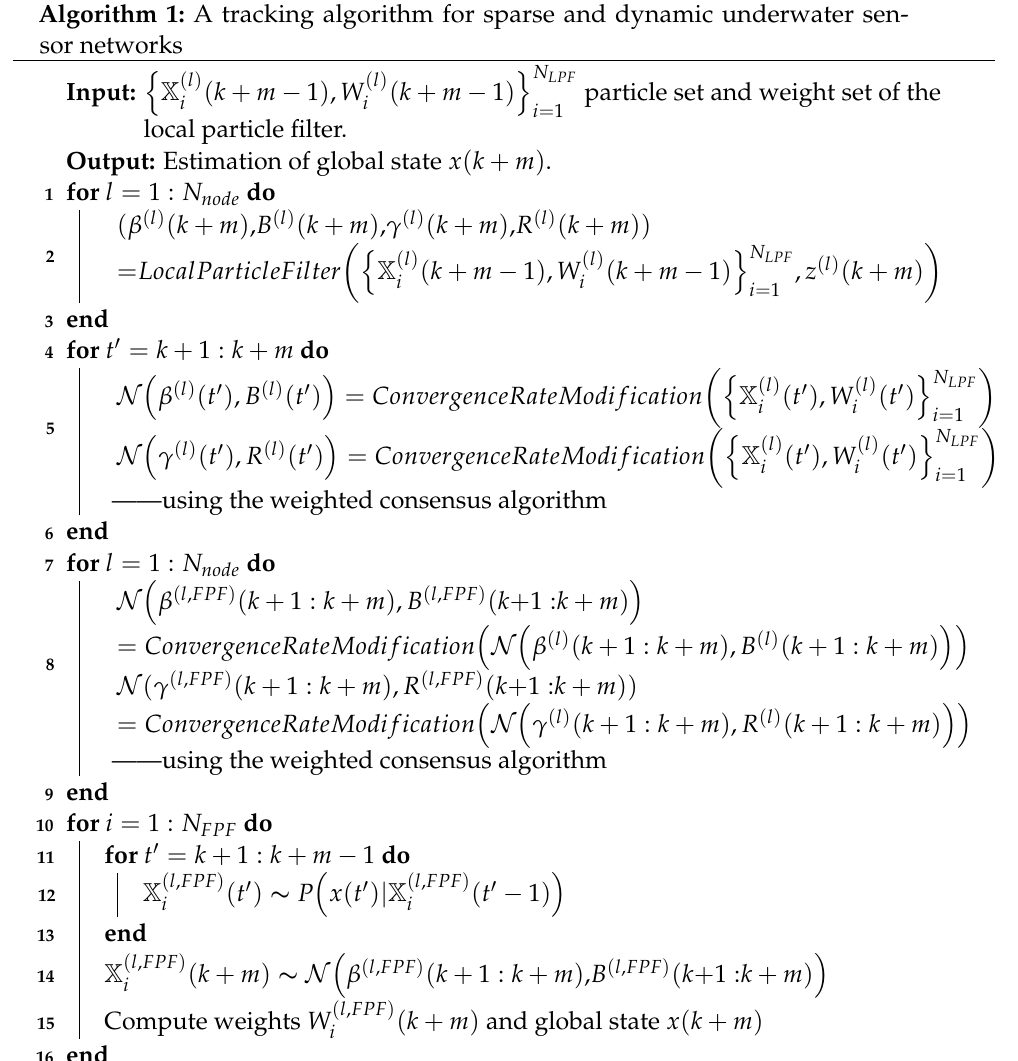
Algorithm 1: A tracking algorithm for sparse and dynamic underwater sen- sor